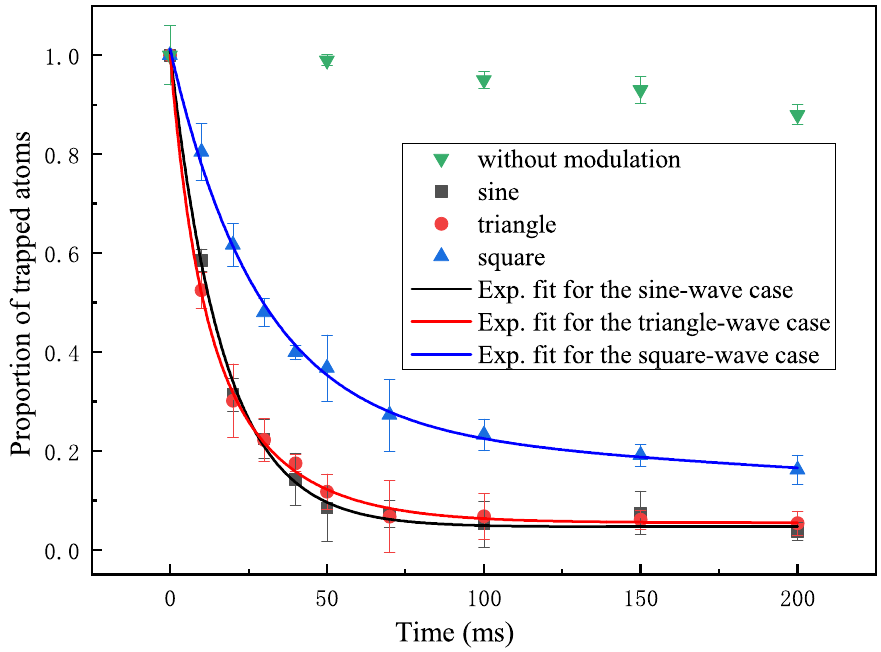
Figure 4. Experimental result (data points) and theoretical fitting (colorful solid lines) of the evolution of the trapped atom population. The modulation frequencies are 2 ω 0 and the modulation depths are 0.15. The green points show an experimental trap loss measurement without modulation as a